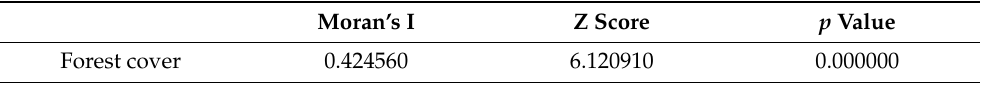
Table 2. Results of global spatial auto-correlation of forest cover in Fujian Province.